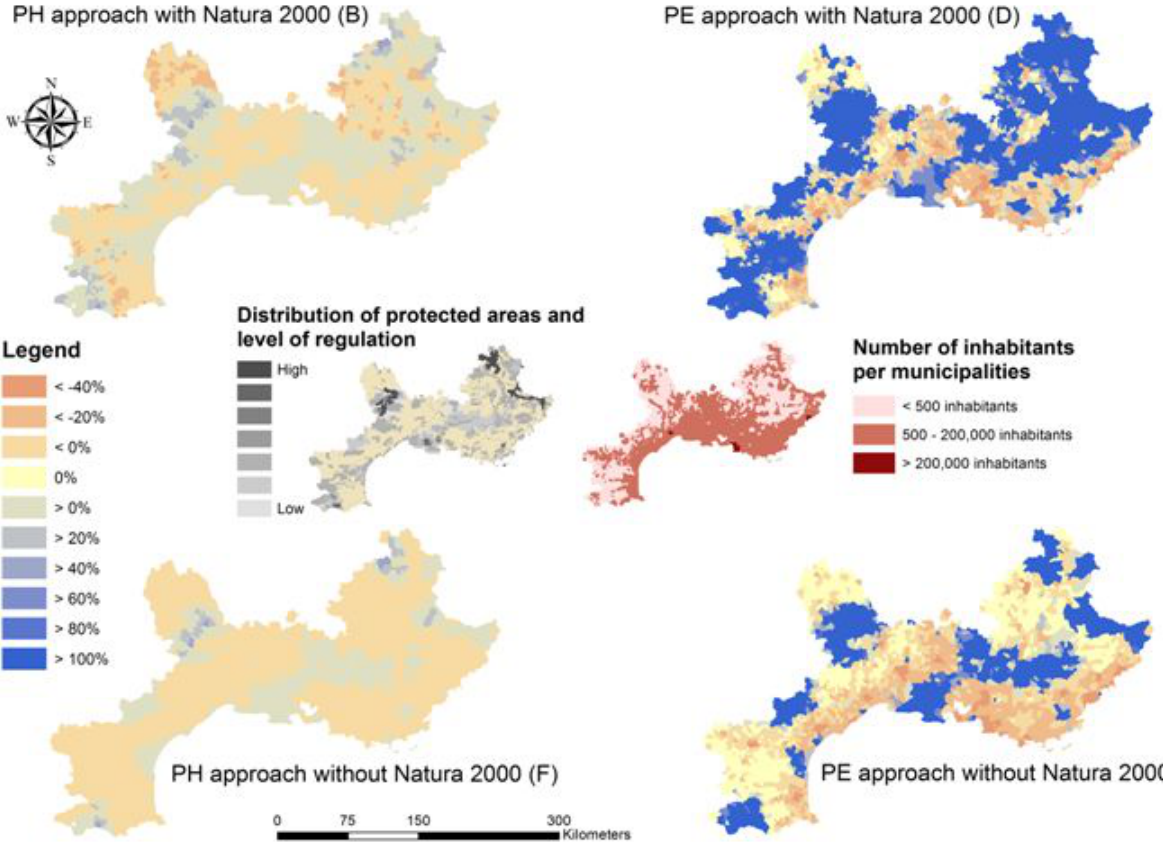
Fig. 2 . Spatial distribution of municipalities receiving increased and reduced fiscal transfers (in %) for four scenarios B, D, F, H in southern France. B and F follow the “per hectare” approach but F disregards Natura 200 sites. D and H follow the “population equivalent” approach but H disregards Natura 200 sites. The level of regulation of protected areas and the number of inhabitants per municipalities are provided to support interpretation of results. PH = per hectare approach, PE = population equivalent